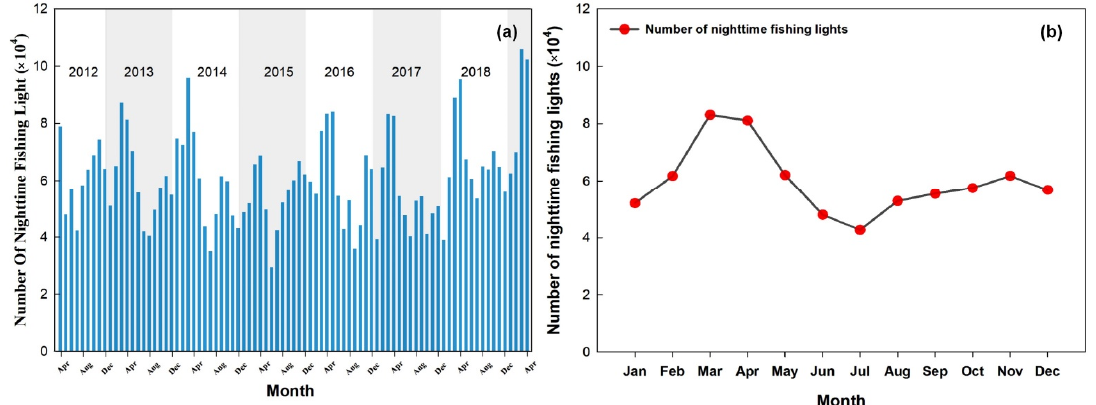
Figure 7. Illustration of nighttime fishing light trajectories in the SCS: ( a ) number of nighttime fishing lights from 2012 to 2019 in the SCS ( b ) annual-averaged results during 2012–2019 in the SCS.